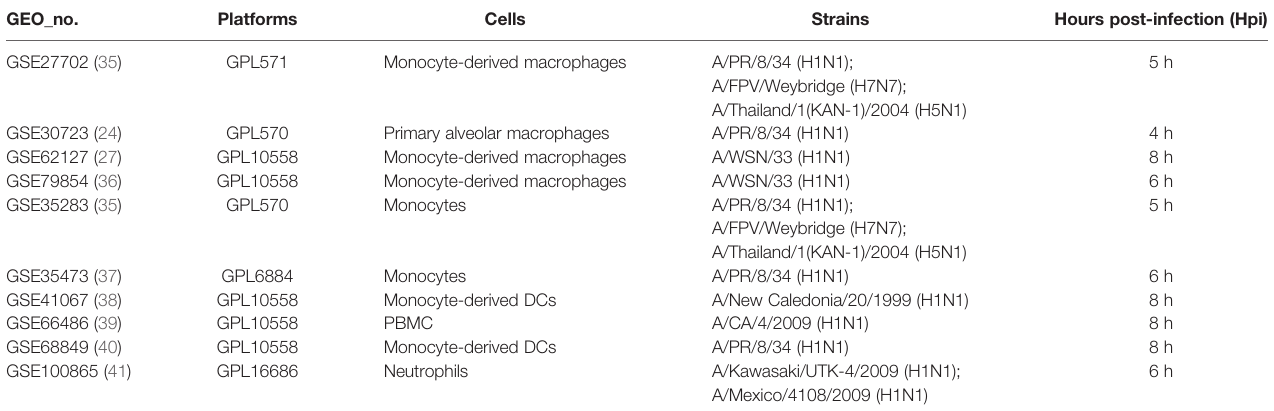
TABLE 5 | The details of gene expression pro fi les on phagocytes from the GEO database. GEO_no.